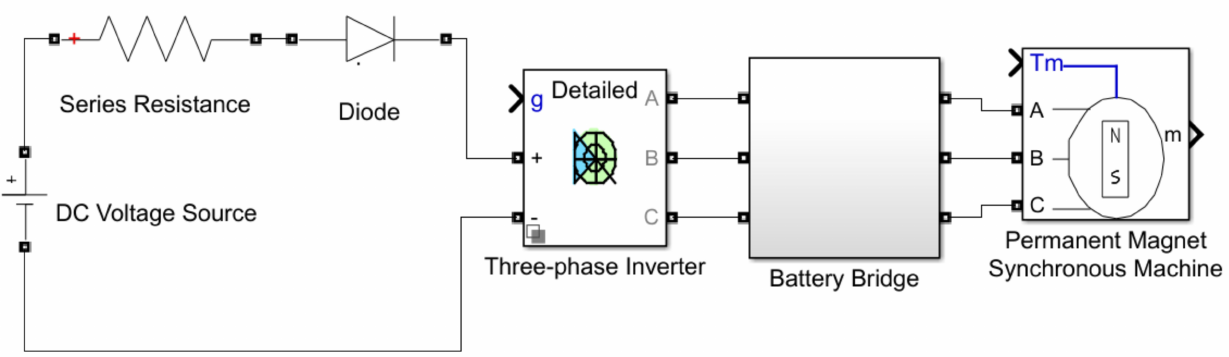
Figure 4. Simplified block diagram of the simulation